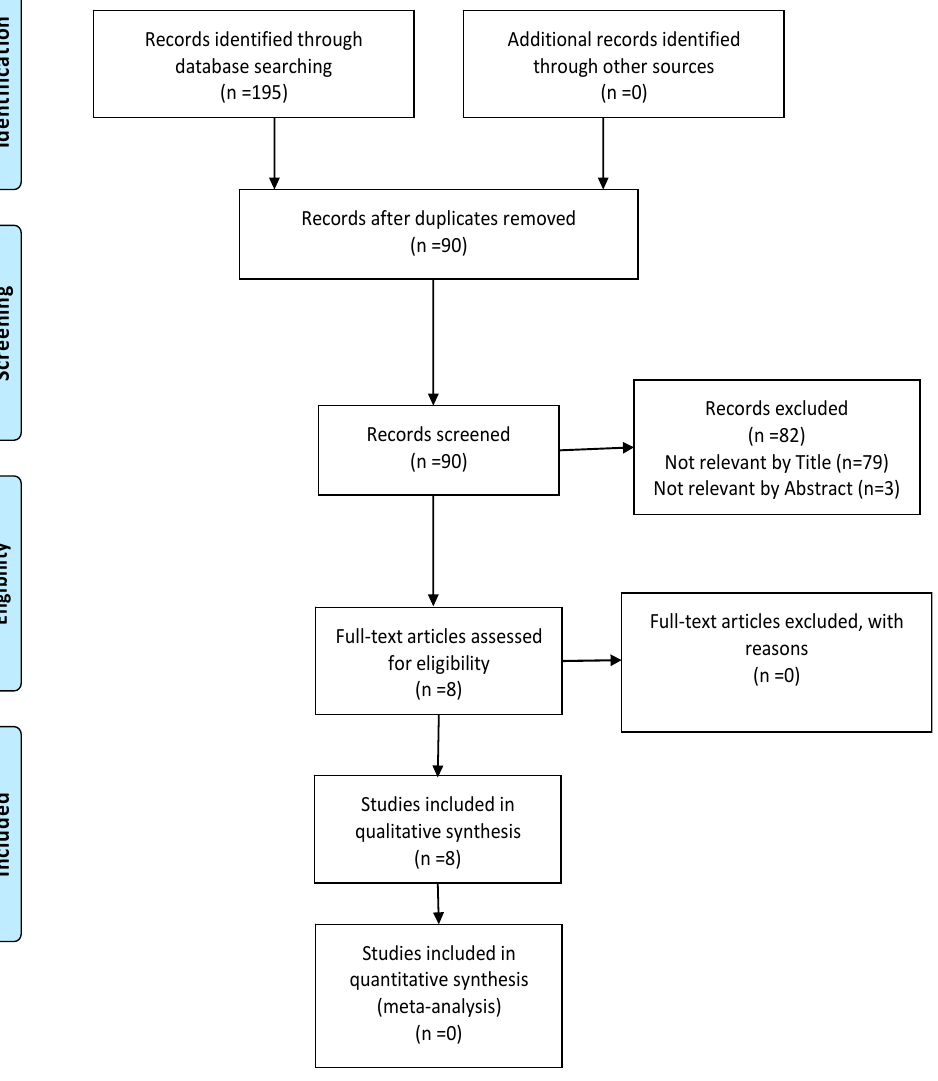
Figure 2. PRISMA flow diagram.